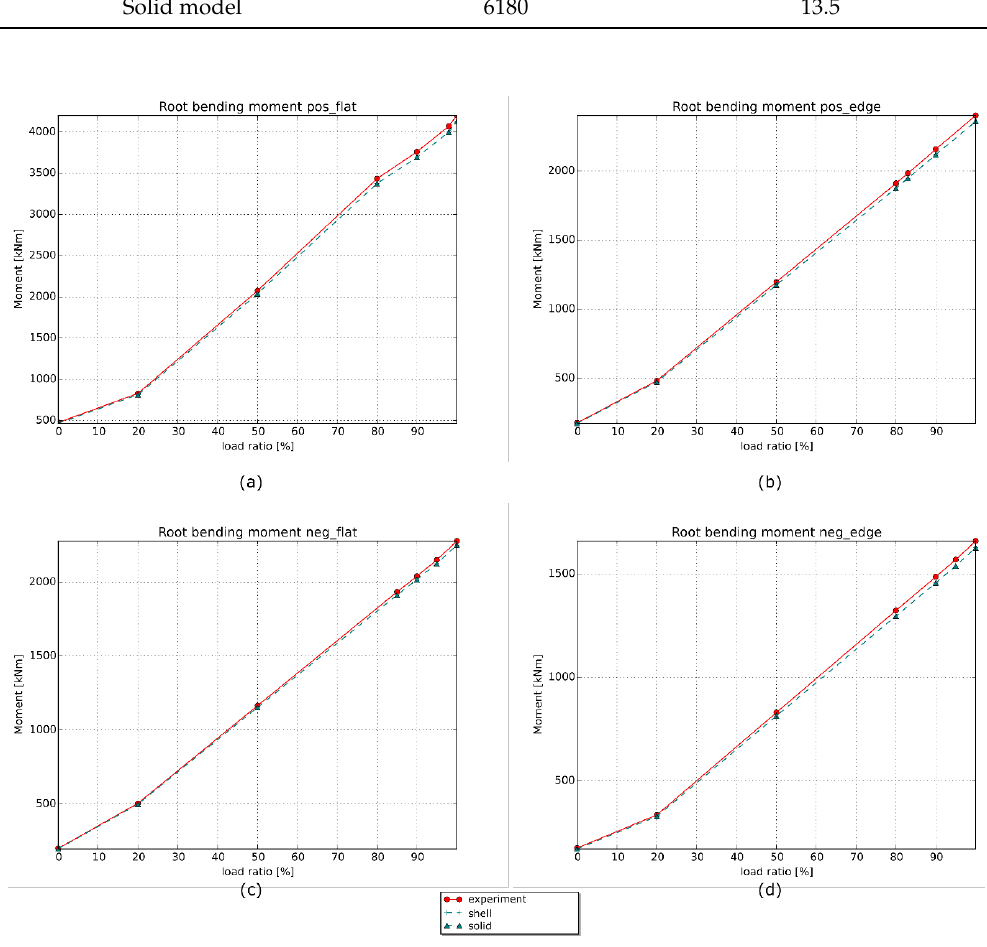
Figure 9. Root bending moment about the x -axis in the lab coordinate system for the different load cases. ( a ) Positive flatwise load case; ( b ) positive edgewise load case; ( c ) negative flatwise load case; ( d ) negative edgewise load case.